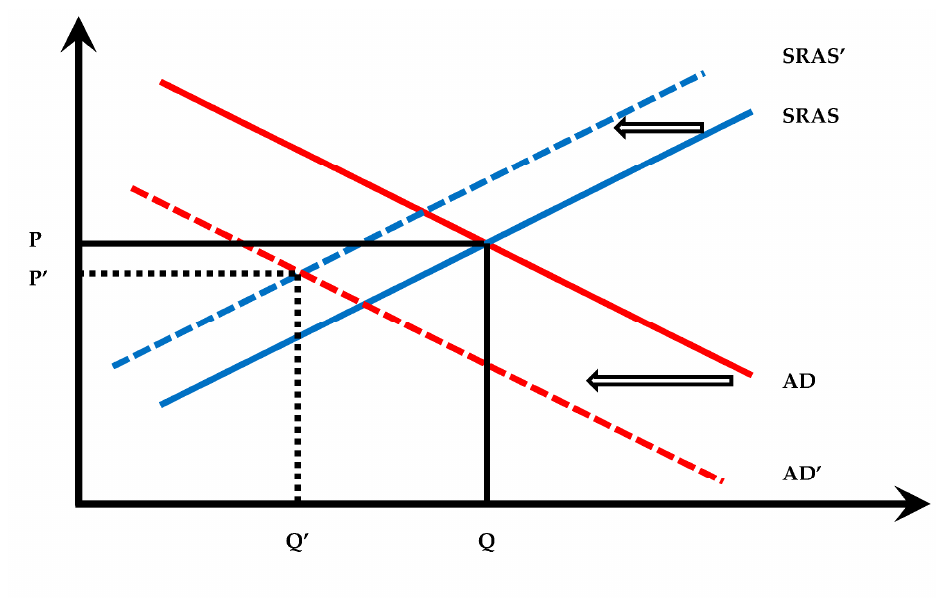
Figure 1. Hypothesized demand and supply shock effects of the COVID-19 pandemic.